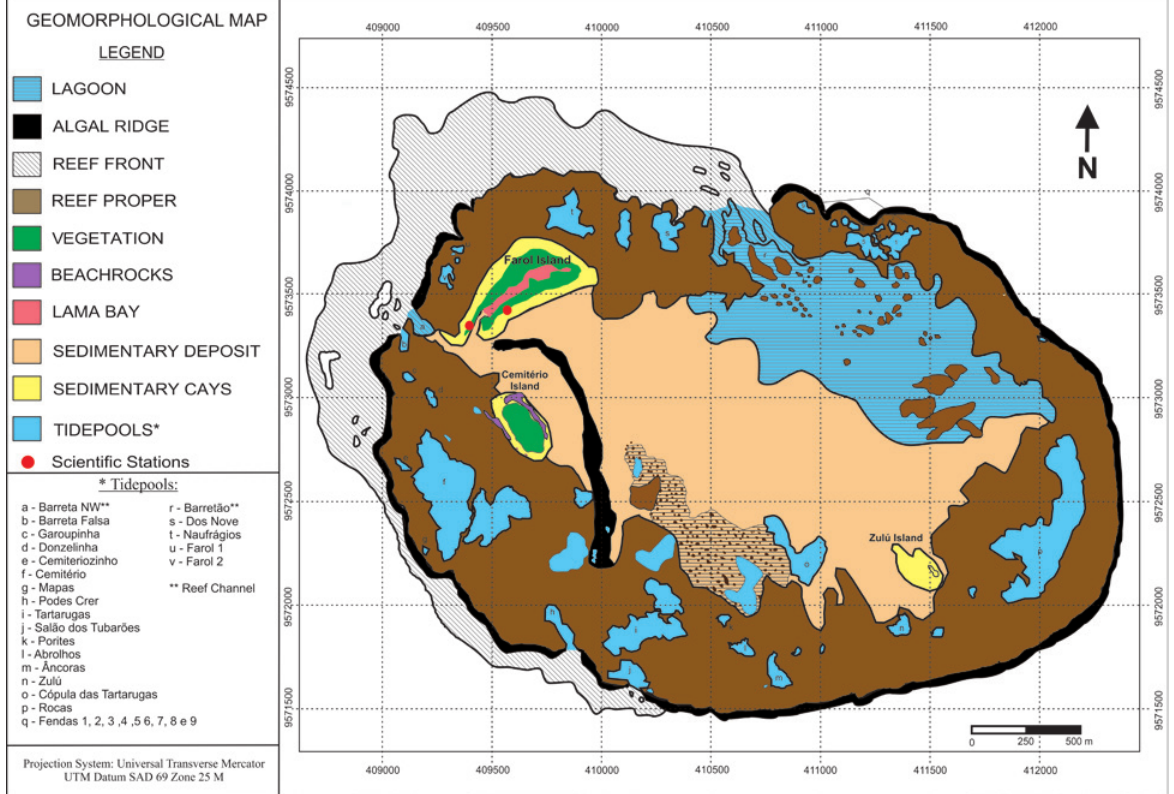
Figure 04 - Geomorphological map of Rocas Atoll. Modified from Pereira et al.